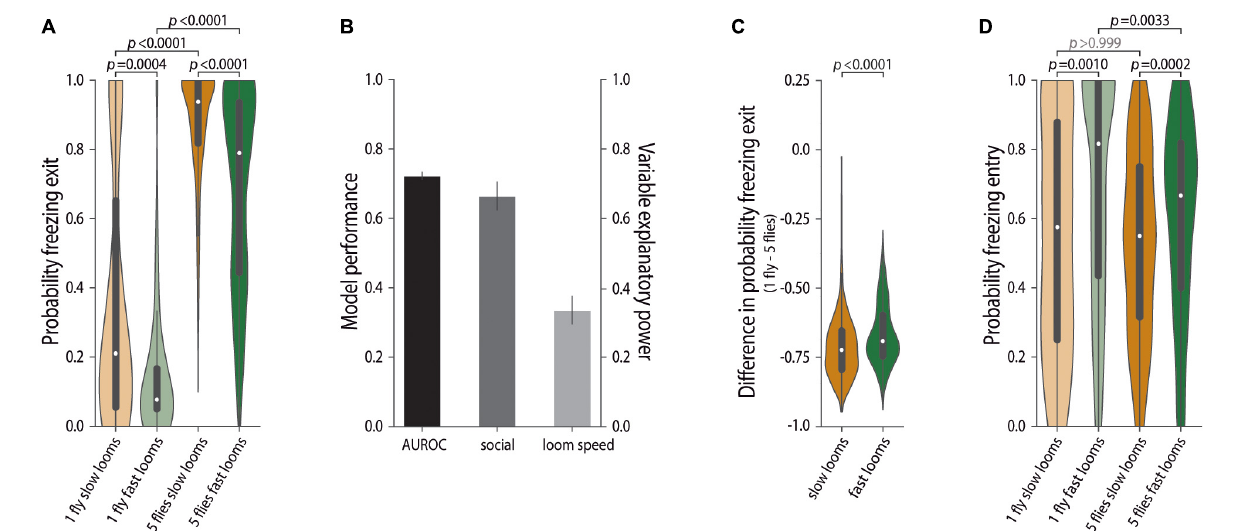
FIGURE 2 | Probability of freezing exit in groups scales with threat imminence. (A,C,D) Violin plots representing the probability density distribution of individual fly data bound to the range of possible values, with boxplots elements: central white dot, median; [box limits, upper (75) and lower (25) quartiles; whiskers, 1.5 × interquartile range]. (A) Probability of freezing exit before the following looming stimulus. P -values result from Kruskal–Wallis statistical analysis followed by Dunn’s multiple comparisons test. (B) Logistic regression model of the decision to stop or continue freezing as a function of social motion cues and looming speed (10,000 bootstrapping events). Mean and standard deviation of model performance (AUROC–area under the receiver operating characteristic curve, black) and explanatory power of the social environment (dark gray) and looming speed (light gray). (C) Difference in the probability of freezing exit between individually tested flies and flies tested in groups for slow and fast looms (refer to the section “Materials and Methods”). P -value results from the two-tailed Mann–Whitney test. (D) Probability of freezing entry upon looming stimulus. P -values result from Kruskal–Wallis statistical analysis followed by Dunn’s multiple comparisons test.